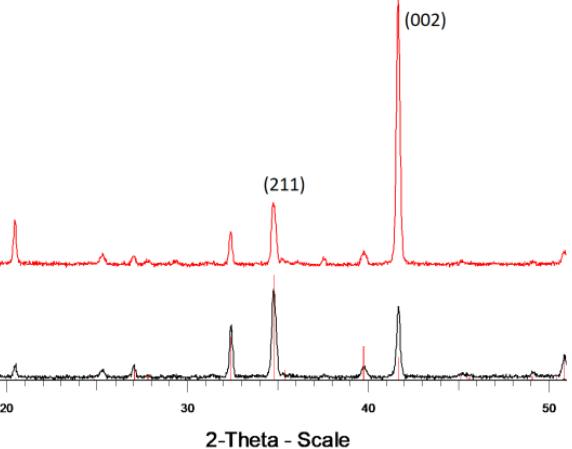
( a ) and 5 h ( b ) and 900 ◦ C for 2 h ( c ).